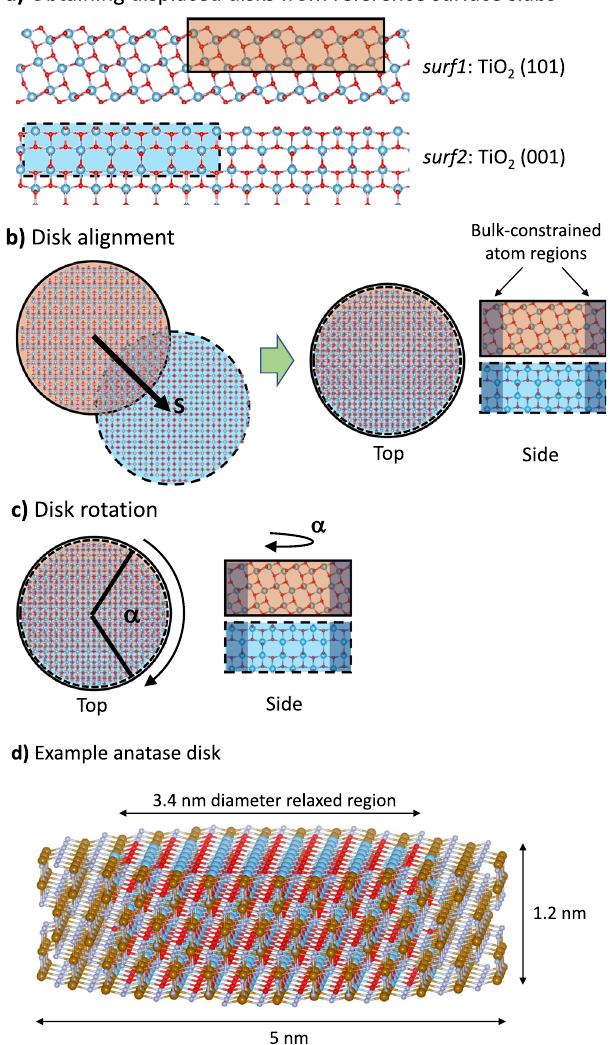
Fig. 1 | Schematic summary of the disk interface approach. In a – c , we show a schematic (not to scale) representation of the process followed to create disk interfacemodelsfortheTiO 2 anatase(101)/(001)interface. a Two s -displaceddisks arecutfromthereferenceTiO 2 (101)and(001)slabs. b Thetwodisksaretranslated by s andorientedsuchthatthe(101)and(001)surfacesfaceoneanother. c Rotation of the (001) disk by angle α with respect to the (101) disk. Grey shading in the side views indicates regions where atoms are constrained during structure/energy evaluation. In d , we show an example of a typical anatase disk. Atom key: uncon- strained/constrainedTiatoms – blue/brown,unconstrained/constrainedOatoms –